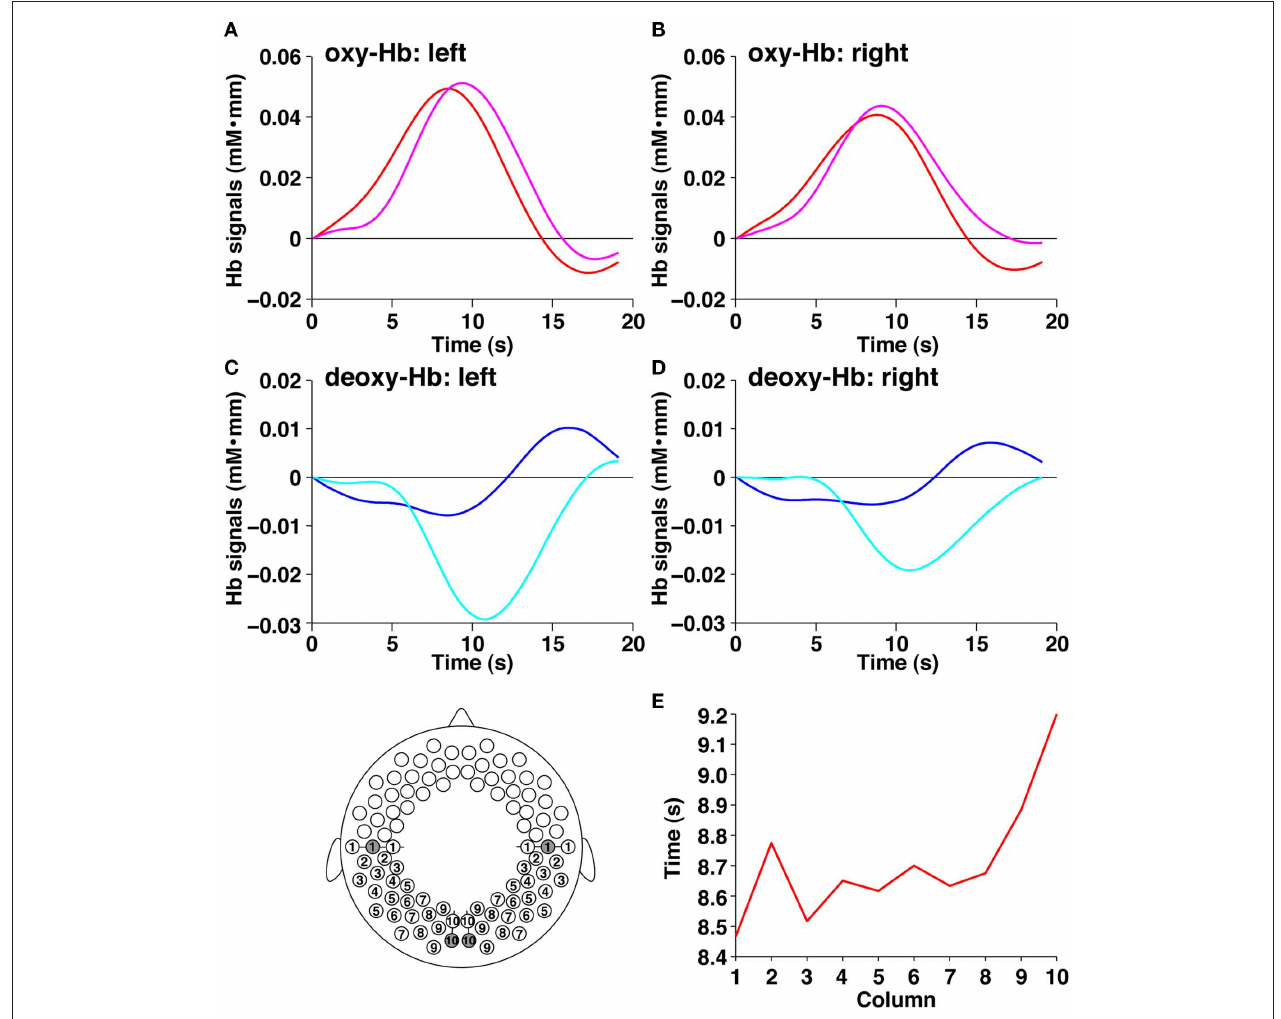
FIguRe 5 | The signal changes in the temporal and occipital channels during period 2. (A) The average time course of oxy-Hb signals in the left hemisphere. The red and magenta lines indicate the temporal and occipital channels, respectively (filled circles in the bottom panel). (B) The average time course of oxy-Hb signals in the right hemisphere. The red and magenta lines indicate the temporal and occipital channels, respectively. (C) The average time course of deoxy-Hb signals in the left hemisphere. The blue and cyan lines indicate the temporal and occipital channels, respectively (filled circles in the bottom panel). (D) The average time course of deoxy-Hb signals in the right